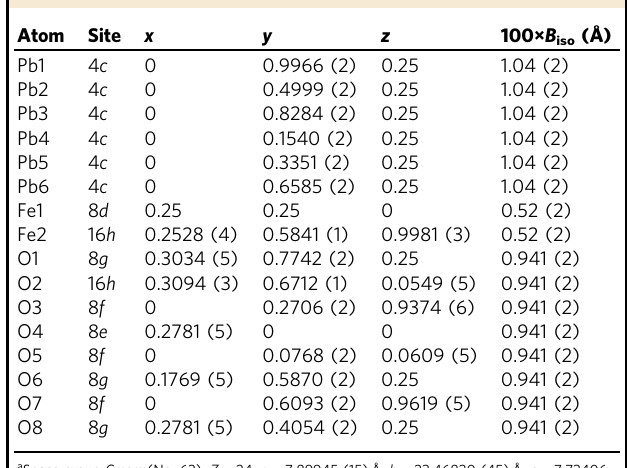
Table 1 Crystallographic parameters of PbFeO 3 re fi ned from NPD pattern at RT a